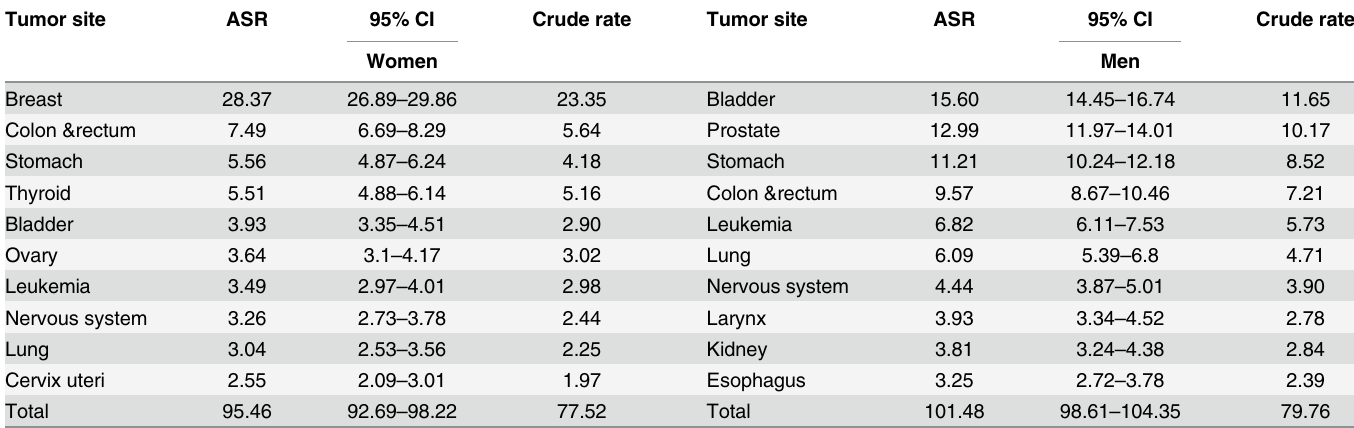
Table 1. Top ten cancers in women and men based on age-standardized rates per 100,000 person-years (ASR) in Fars province, Iran, 2007 – 2010. Tumor site